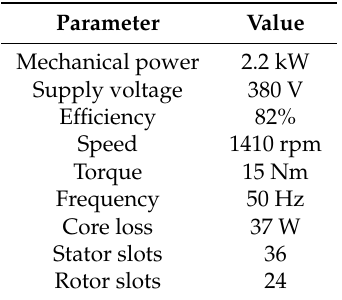
Table 2. Mesh parameters of the FEM model.